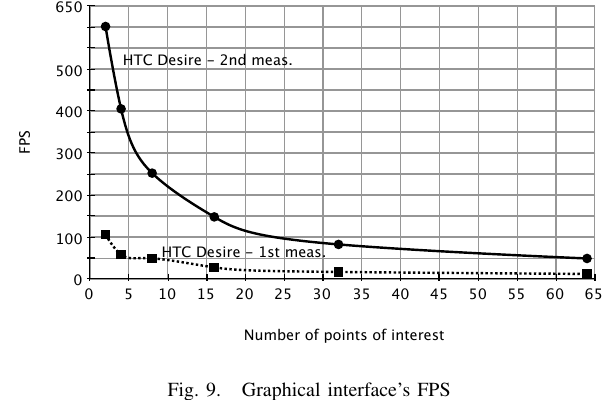
Fig. 9. Graphical interface’s FPS